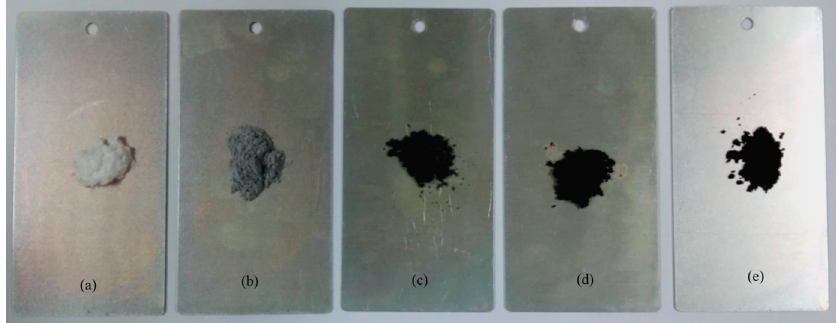
Figure 4. Photographs of microPCMs samples, ( a ) MG-0; ( b ) MG-2; ( c ) MG-4; ( d ) MG-6, and ( e ) MG-8. Table 1. Characters of microcapsules with various graphene contents in the shells.